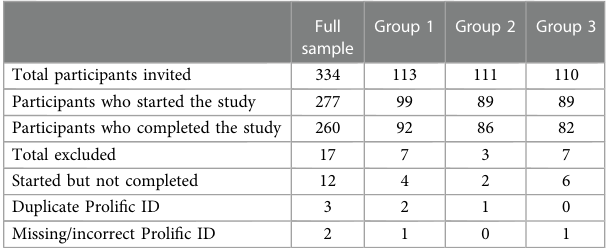
TABLE 2 Study sample and excluded